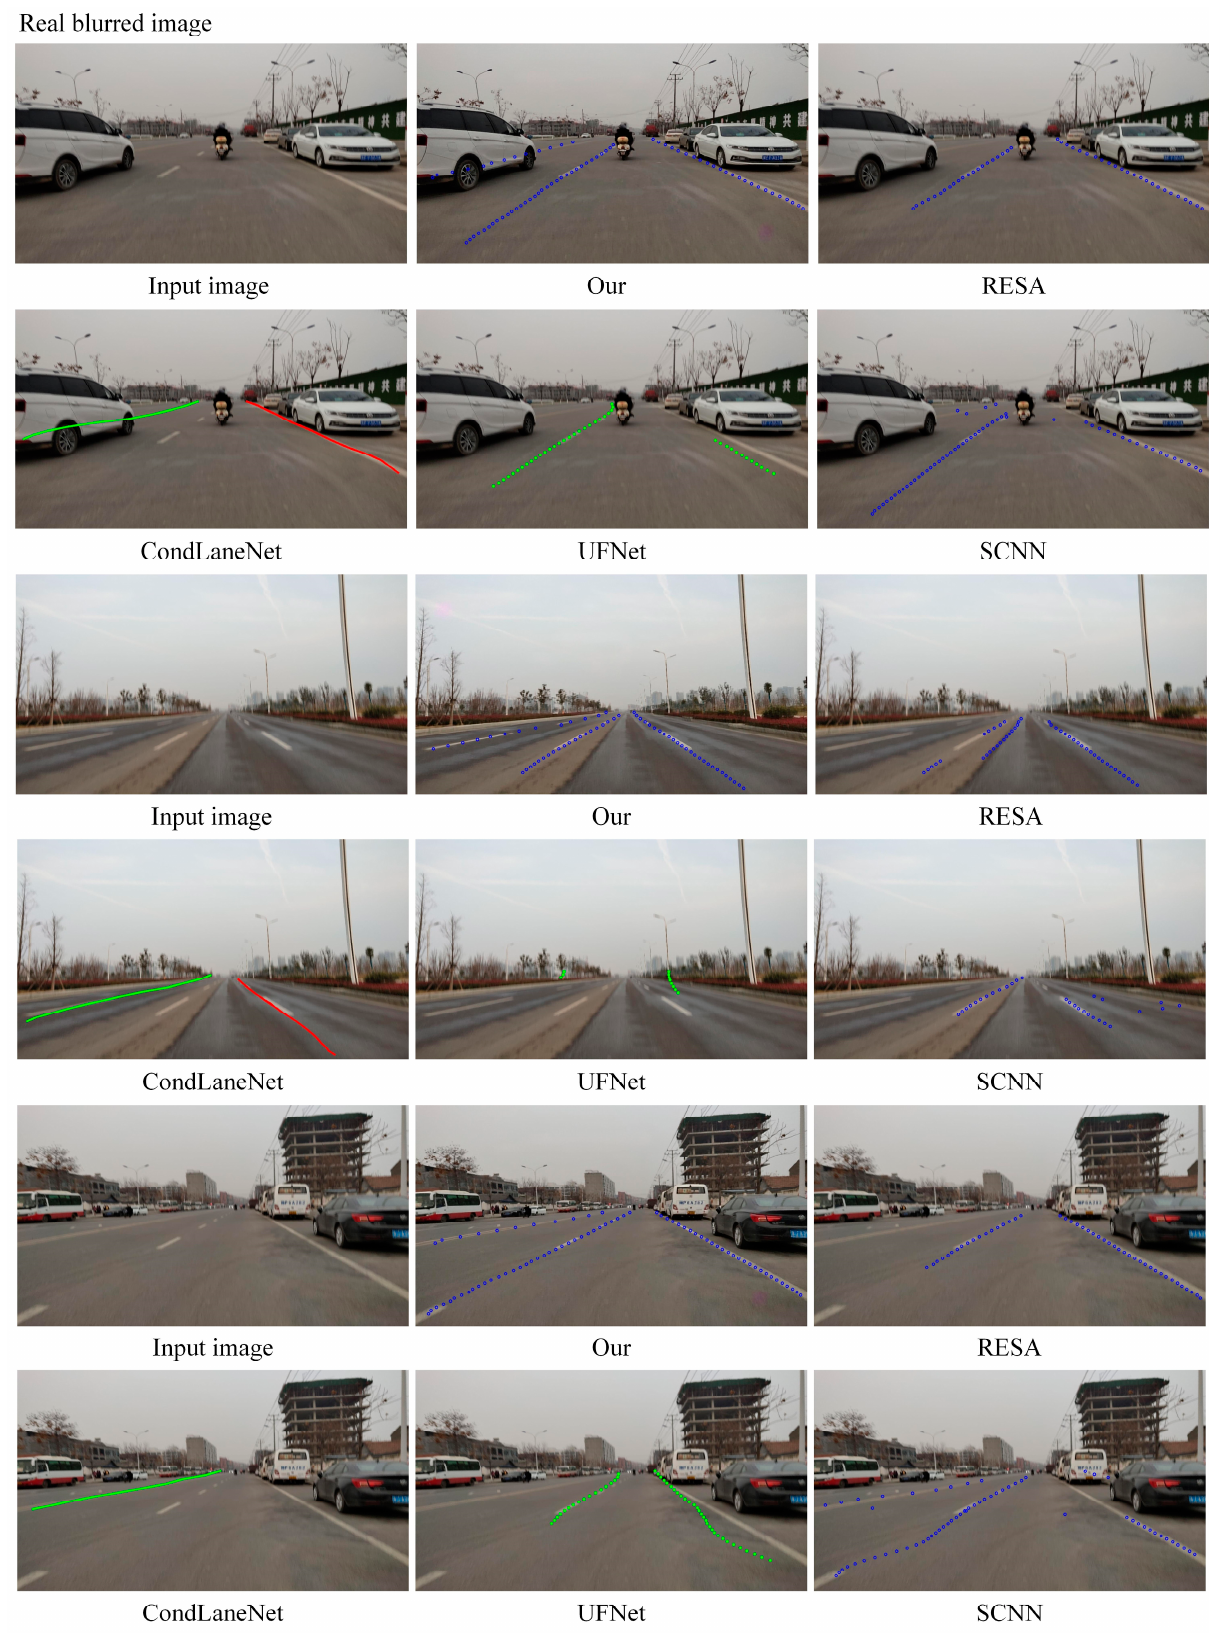
Figure 8. Example of lane detection results based on three sets of images with different detection models.